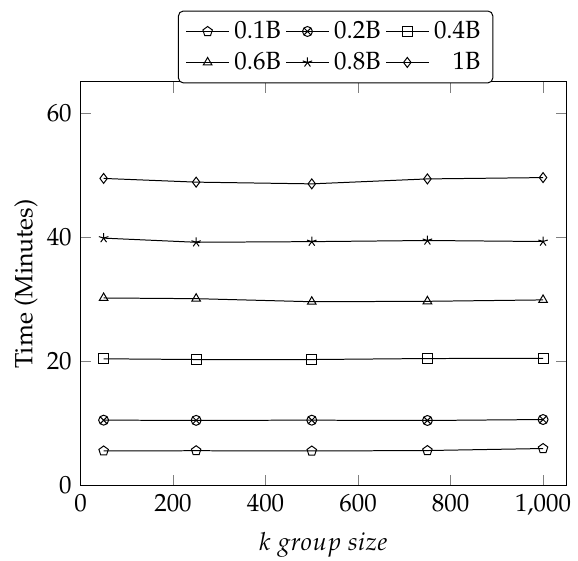
Figure 7. Performance against the # of